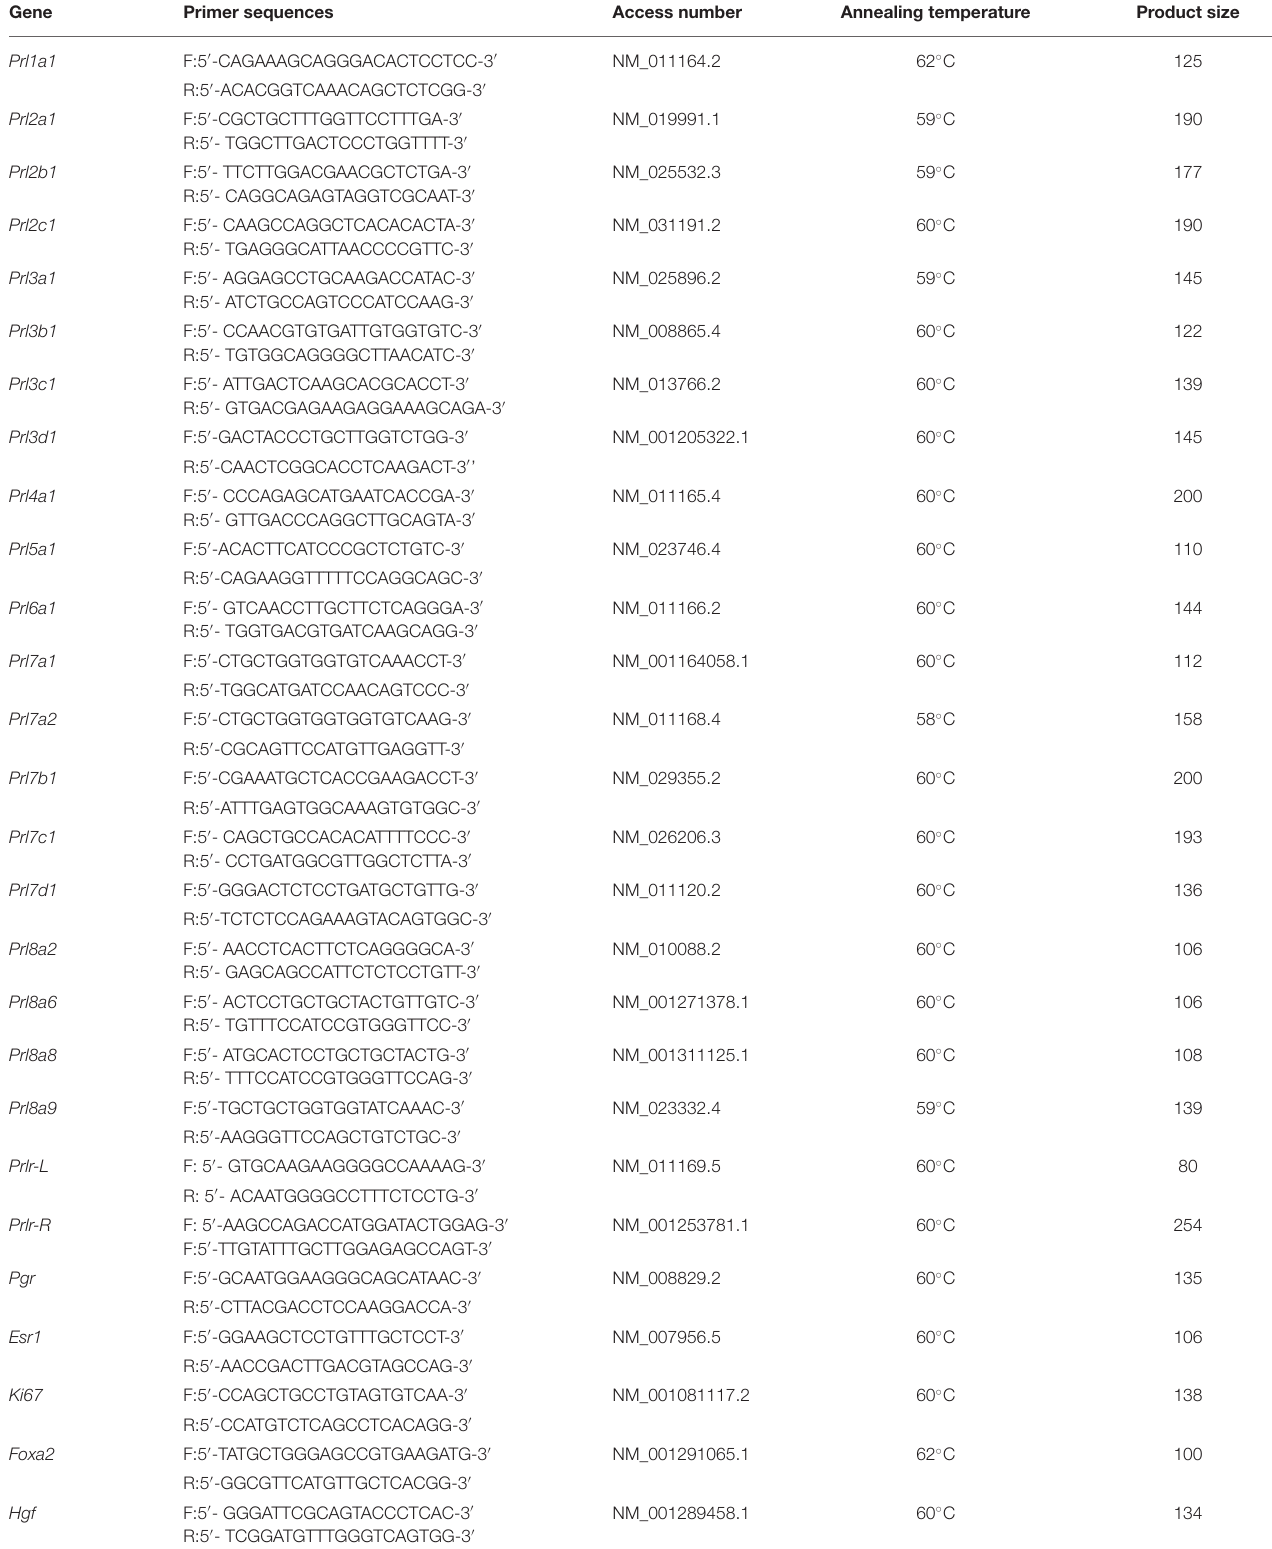
TABLE 1 | Characteristics of primers and quantitative real-time PCR reaction conditions used in the study. Gene Primer